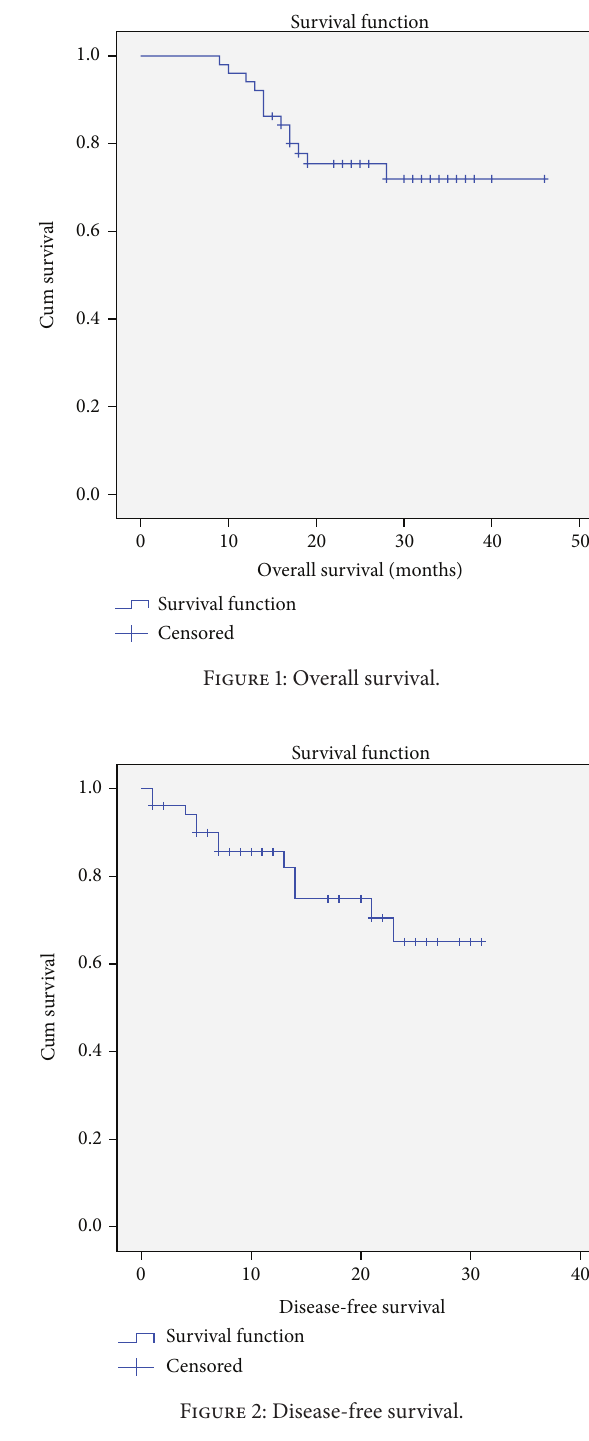
Figure 2: Disease-free